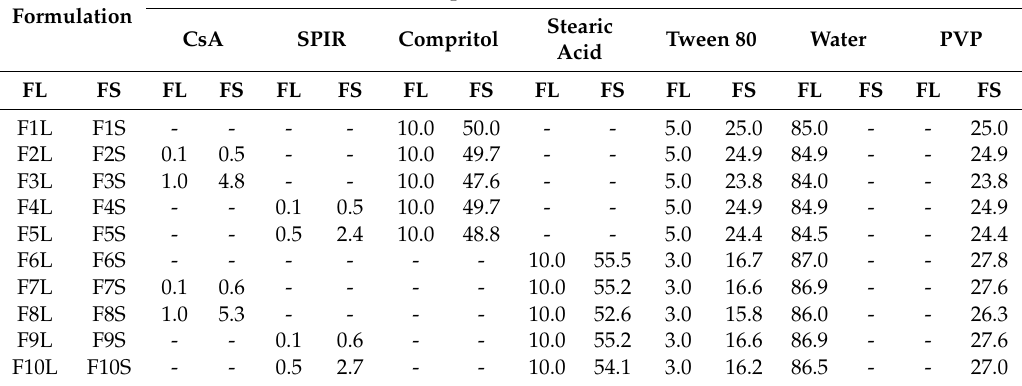
Table 1. The composition ( w / w %) of the investigated formulations before (FL—liquid formulations) and after (FS—spray-dried formulations) spray drying. CsA: cyclosporine A, SPIR: spironolactone and PVP: polyvinylpyrrolidone. The Composition of Formulations (FL and Formulation